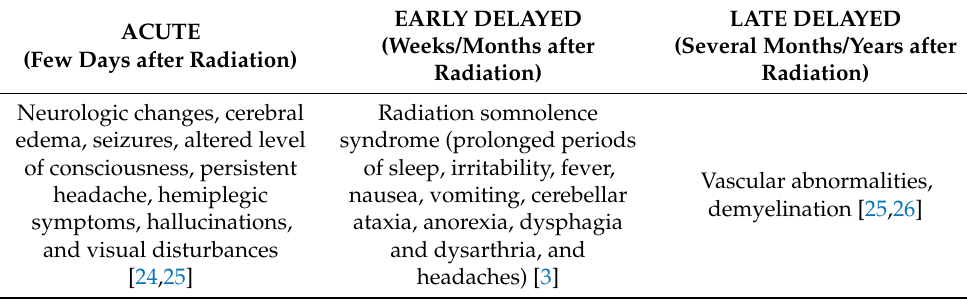
Table 2. Signs and symptoms due to radiotherapy toxicity subdivided according to time of